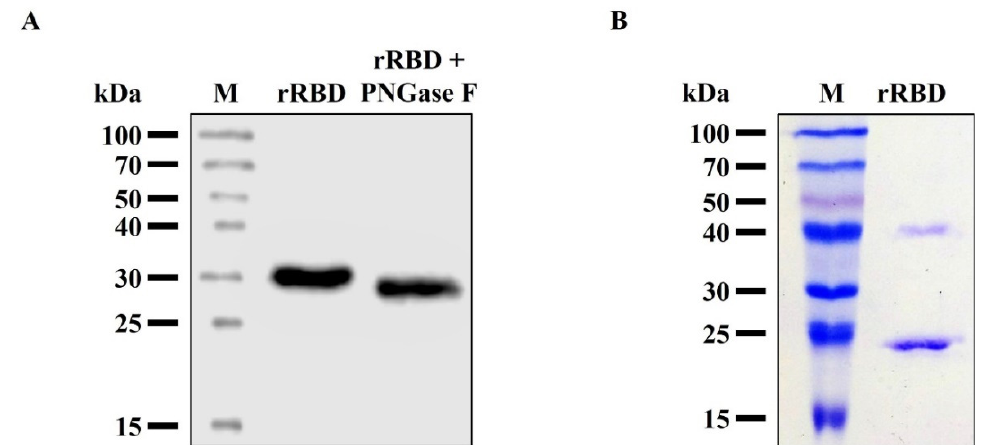
Figure 6. Characterization of purified rRBD. ( A ) rRBD glycosylation analysis. N-glycosidase F-mediated in-vitro deglycosylation of purified rRBD. Western blot in reducing condition developed with anti-S antibody. ( B ) Analysis of purified rRBD by SDS-PAGE in non-reducing condition. Lanes: M, protein marker; rRBD, purified rRBD; rRBD + PNGase. F, purified rRBD treated with N-glycosidase F.